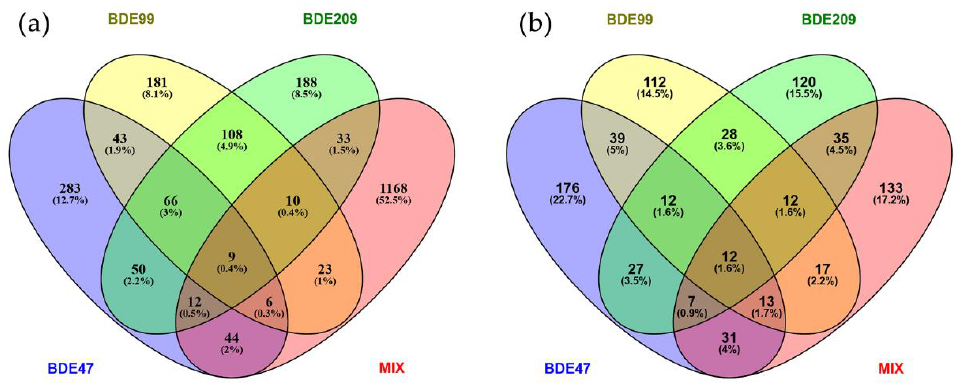
Figure 1. Venn diagrams of the ( a ) genes and ( b ) proteins differentially expressed in HepG2 following treatment for 72 h with BDE-47, -99, -209 and their ternary mixture (MIX) at 1 nM. Along with protein-coding transcripts, a total of 156 lncRNAs (DELs) were identified within DEGs (Table S1): 23 were specific for BDE-47 treatment, 16 for BDE-99, 11 for BDE-209, 71 for the MIX, and several were shared by two or more treatment conditions. In particular, seven DELs ( AC008966.1 , AC093510.1 , AL121899.1 , CSNK1G2-AS1 , CSTF3-DT , LINC01004 , LOC114224 ) were shared by BDE-47 and -99 conditions with same modula- tion, except AC008966.1 which was repressed by BDE-47 and induced by BDE-99. Three DELs were induced by both BDE-47 and -209 ( AC245297.4 , LINC00482 , LINC01348 ), seven DELs were induced by both BDE-99 and 209 ( AL359878.2 , LINC00917 , LINC02370 , NEAT1 , RMRP , SRRM2-AS1 , ZNF503-AS2 ), and seven DELs were induced by all the three single congeners ( AC004540.1 , AC005523.2 , AC020928.1 , BAALC-AS1 , HAGLR , SND1-IT1 , TTTY18 ). Only the lncRNA AC010883.1 was shared among all the treatment conditions, being induced by the single congeners and repressed by the MIX.